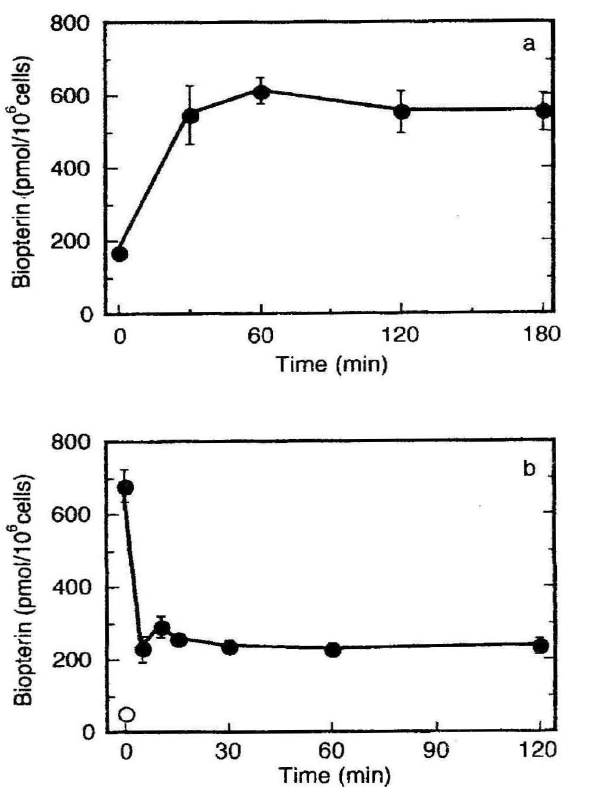
Figure 1: Uptake of tetrahydrobiopterin and release of biopterin (total biopterin) by RBL2H3 cells. (a) RBL2H3 cells at a density of 105 cells/well of 96- well analytical culture plate were given 200 11M 6R-L erythro-tetrahydrobiopterin (6RBH4 in 100 Ill). At indi cated times, cells were quickly washed 3 times within 5 sec with DPBS. Then the cells were subjected to biopterin measurement after iodine oxidation under acid conditions (mean ± S.D., n=4). (b) CelIs were fed 200 11M 6RBH for 60 min. Then, the culture medium was 4 replaced with new medium without BH 4. Subsequently, cellular biopterin was measured at indicated times after the medium renewal. Endogenous biopterin level is indi cated with an open circle. Each point indicates the mean ± SD for 4